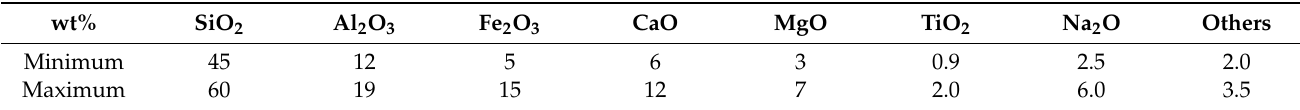
Table 1. Chemical composition of the BFs used in this